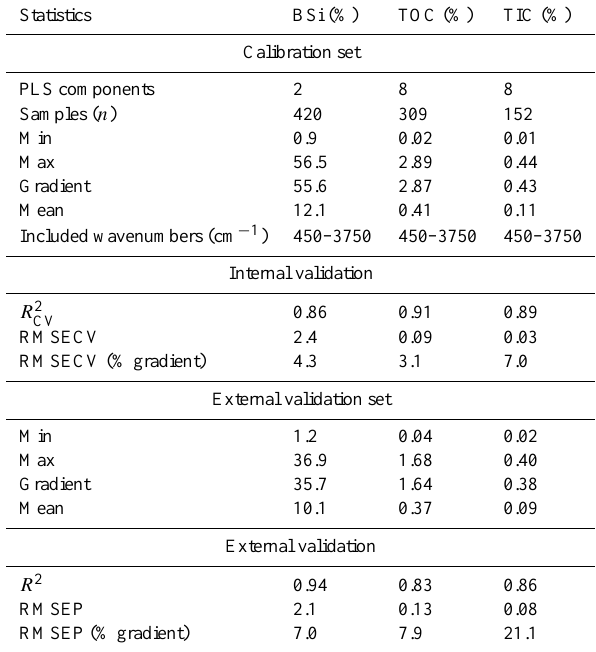
Table 1. Statistical performance of developed calibration models for biogenic silica (BSi), total organic carbon (TOC), and total in- organic carbon (TIC) based on sediments from Lake